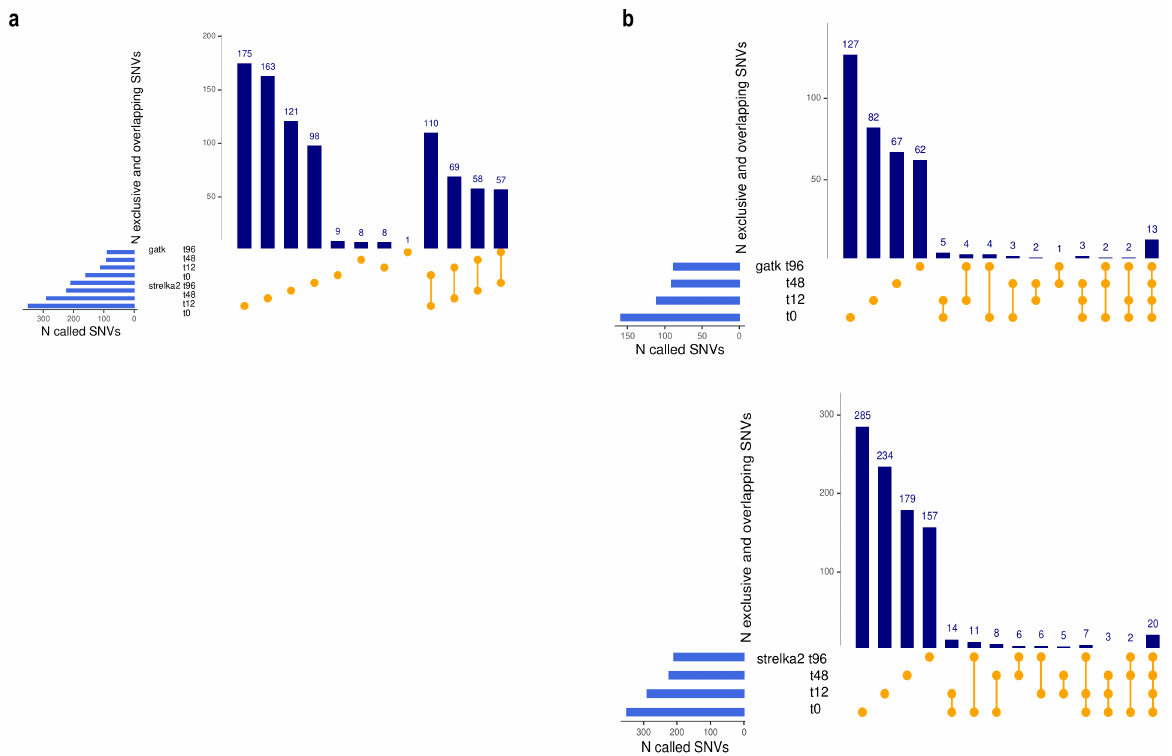
Figure 2. ( a ). Concordance between GATK and Strelka2 in variant calling from individual cell alignments. A higher number of SNVs were called by Strelka2, which also identifies the vast majority of the GATK calls. Note that the UpSet plots show the first 12 of all possible overlaps. ( b ). Shared and exclusive sceSNVs called by GATK (top) and Strelka2 (bottom) from scRNA-seq data generated at four time-points during drug treatment, showing the low overlap indicative of de novo